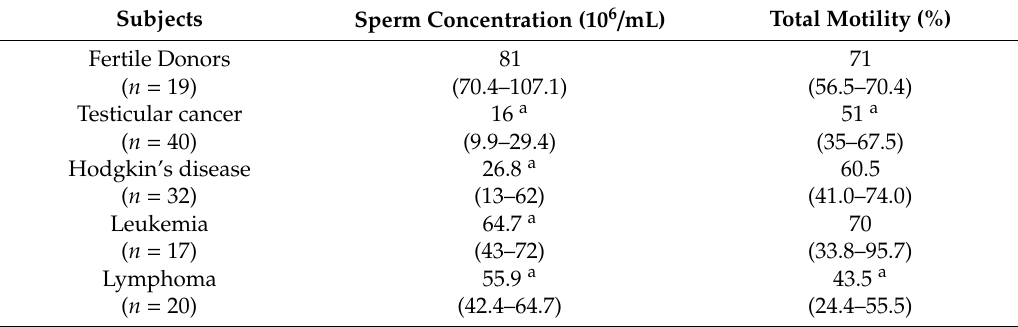
Table 1. Semen parameters of di ff erent types of cancer patients compared with fertile